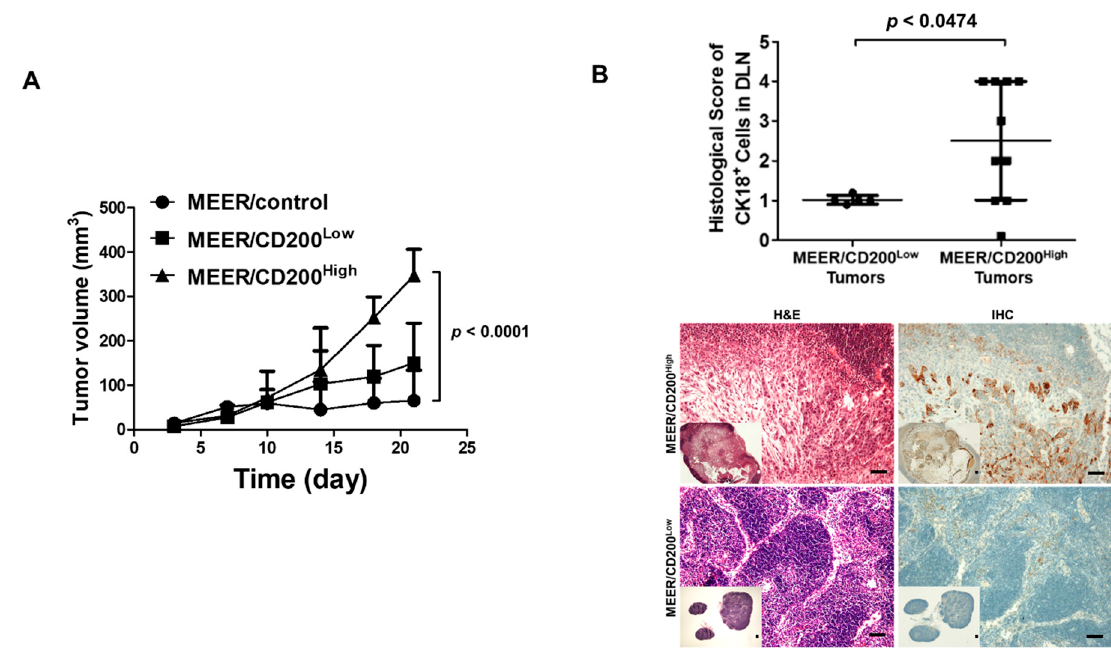
Figure 5. CD200 overexpression enabled MEER tumors to metastasize to DLNs. ( A ) One million MEER cells were subcutaneously implanted into C57BL6 mice. When the tumors were approximately of 200–300 mm 3 , the tumors, DLNs, and major organs were harvested. CD200 expression was analyzed to confirm expression di ff erences between MEER / CD200 High and MEER / CD200 High tumors. The DLNs were sectioned to detect metastasis using an anti-CK18 antibody, and the numbers of metastases were histologically evaluated. ( B ) The frequency of metastasis in mouse DLNs was 100% (8 mice per group). DLNs were sectioned to count metastatic cells and were immunostained for CK18 + . The metastatic cells from MEER / CD200 High tumors were histologically scored compared to metastatic CK18 + cells of MEER / CD200 Low tumors, which were assigned a metastatic score of 1. The bar in macroscopic image indicates 100 µm.